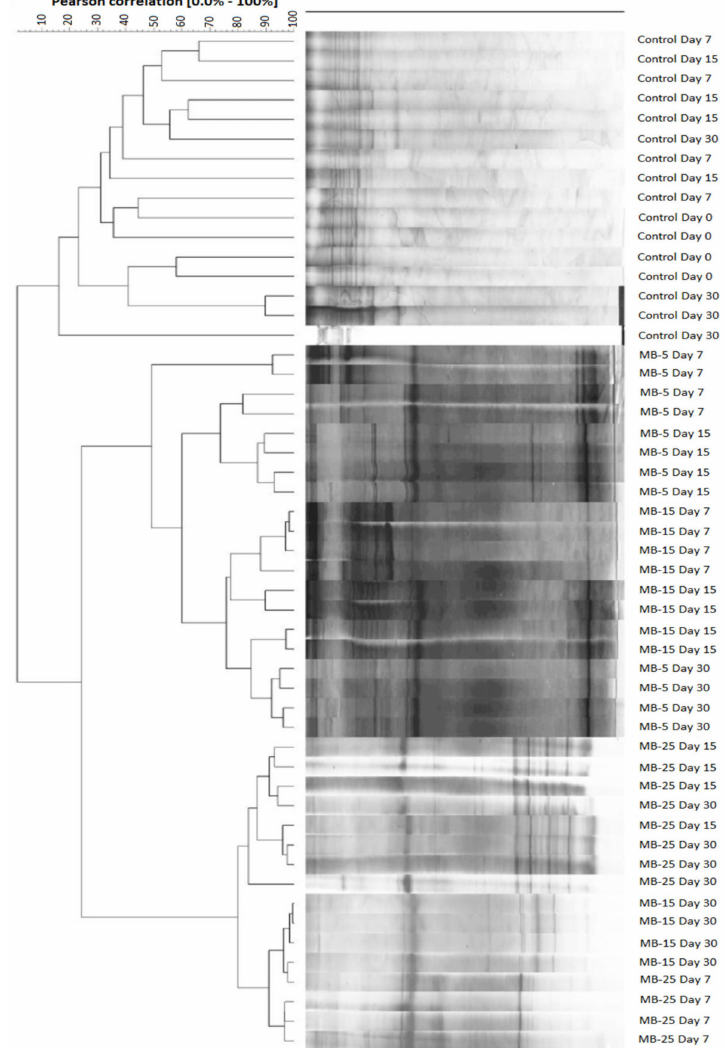
Figure 1. Clustering based on pairwise similarity index of DGGE patterns obtained from intestinal samples of juvenile S. aurata fed experimental diets for 30 days. Codes are: MB-5: 5% microalgae blend meal inclusion; MB-15: 15% microalgae blend meal inclusion; MB-25: 25% microalgae blend meal